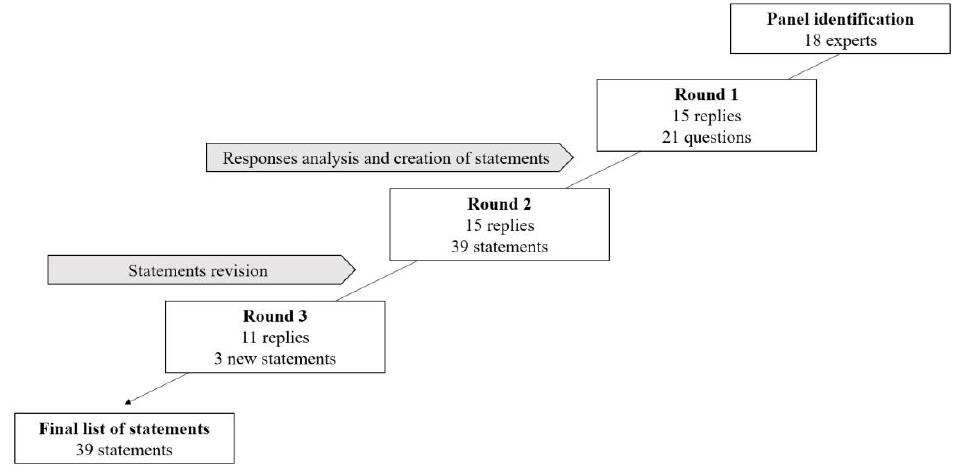
Figure 1. Flowchart of the Delphi process.